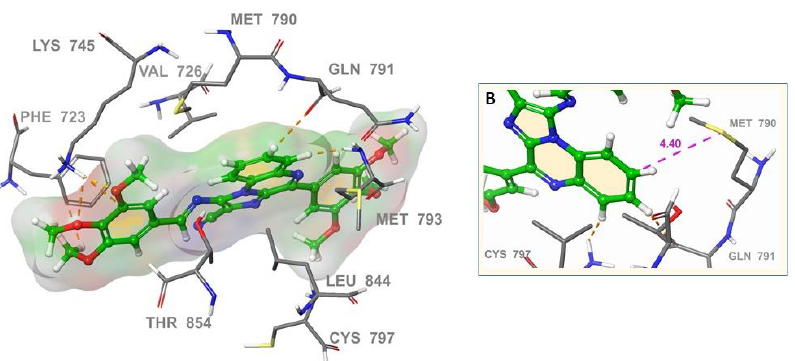
Figure 5. ( A ) 3D docking pose of 6b at the active site of EGFR L858R/T790M (PDB code 5C8K) showing binding and important interactions with some of the important amino acid residues. Some residues are removed for clarity; ( B ) close-in image of 6b presenting the position of the imidazo[1,2- a ]quinoxaline core and the methionine gatekeeper sulfur.